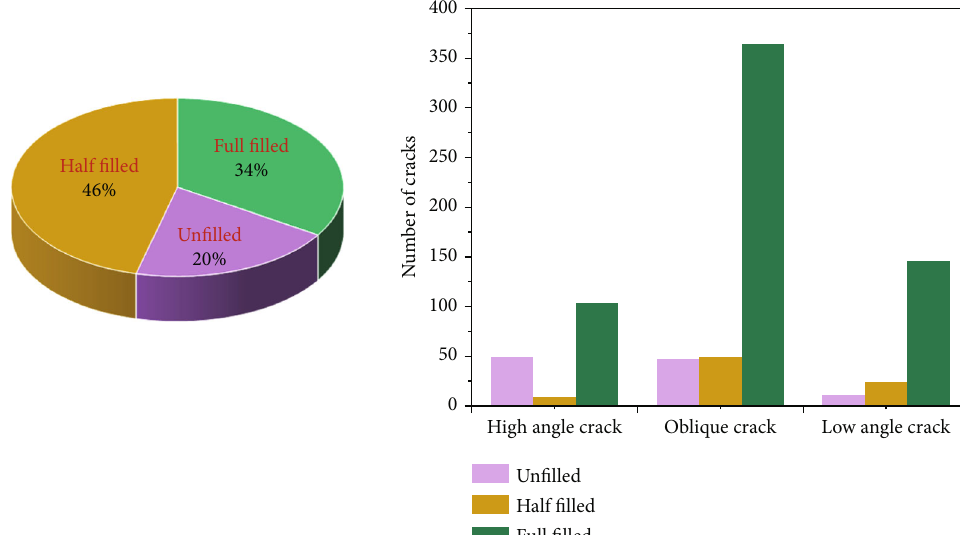
Figure 1: Characteristics of Carboniferous fractures in Chepaizi area.